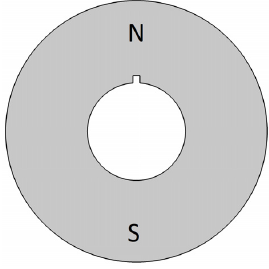
Figure 7. Rotor (only one type).